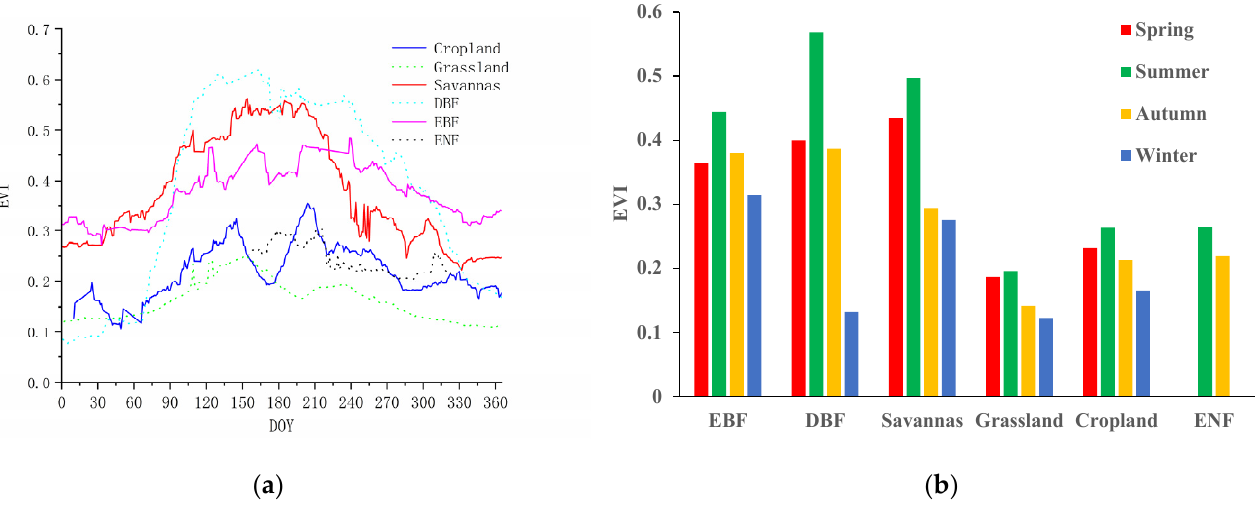
Figure 6. The distribution of daily vegetation index (EVI) and seasonal statistics of EVI for each selected study site. ( a ) Vegetation index; ( b ) Statistics of seasonal EVI.